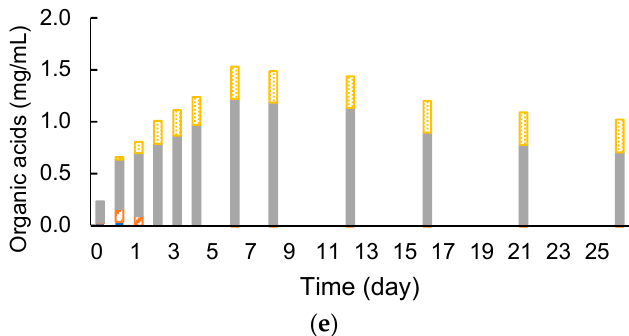
Figure 4. Cultivation of C. cellulovorans , CCeM, and MFMP with Avicel. ( a ) Cell growth, where C. cellulovorans ( ○ _open circle), CCeM ( ● _closed circle), and MFMP ( Δ _open triangle) are included; ( b ) total sugar concentration; ( c ) time course of total sugar, where C. cellulovorans ( ○ _open circle), CCeM ( ● _closed circle), and MFMP ( Δ _open triangle) are included; ( d ) time course of gas production, where total gas volume ( ● _closed circle) and methane volume ( Δ _open triangle) are included; ( e ) time course of organic acids concentration of CCeM, where lactic acid (closed bars), formic acid (open bars), acetic acid (closed bars), and propionic acid (dotted bars) are included. Values with error bars are mean ± SE of three independent samples. SE means a standard error. An asterisk indicates a significant difference ( p < 0.05).